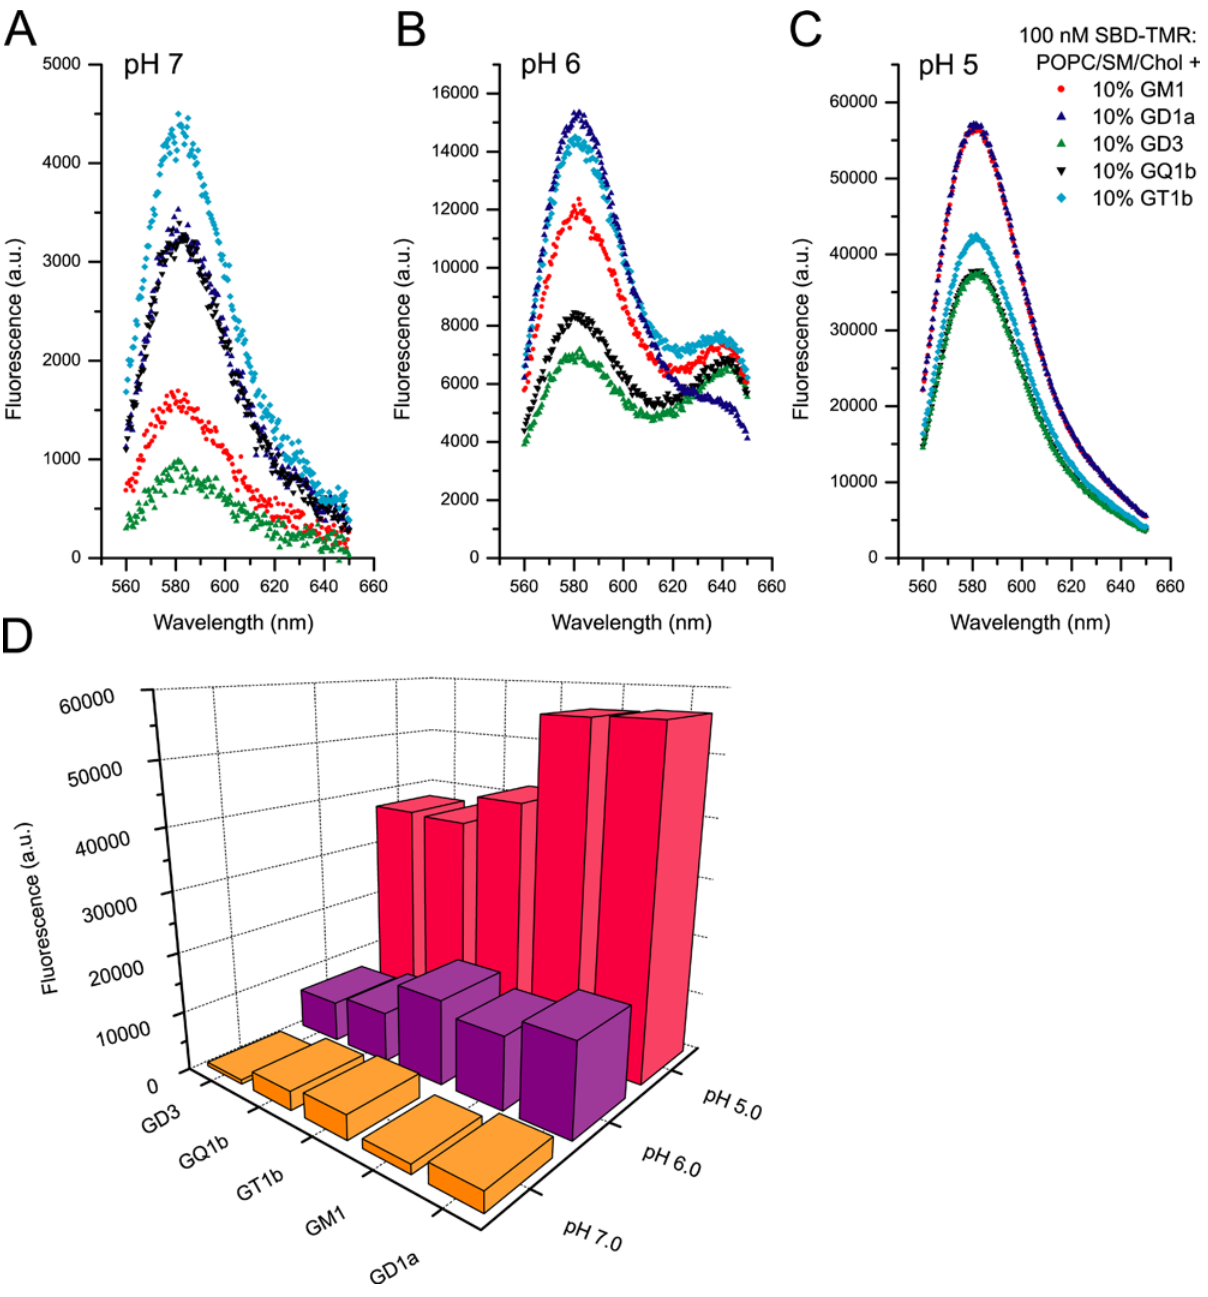
Figure 4. SBD preference for particular gangliosides depends on pH, and interaction with raft-ganglioside mixtures is strongly enhanced at low pH. Spectrofluorimetric liposome binding assay of 100 nM of SBD-TMR with the raft-like ternary mixture POPC/SM/Chol (45:25:30 mol%). 10% of the given ganglioside was incorporated into the lipid membrane: GM1 (red N ), GD1a (blue m ), GD3 (green m ), GQ1b (black . ) and GT1b (cyan ¤ ). A, B and C are the fluorescence spectra taken at pH 7, 6 and 5 respectively. D summarizes the comparative fluorescence responses at 580 nm for the various gangliosides at different pH.